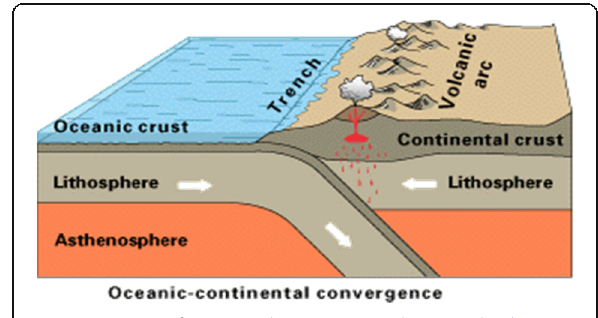
Fig. 2 Depiction of tectonic plate movement. https://upload. wikimedia.org/wikipedia/commons/thumb/2/29/Active_Margin.